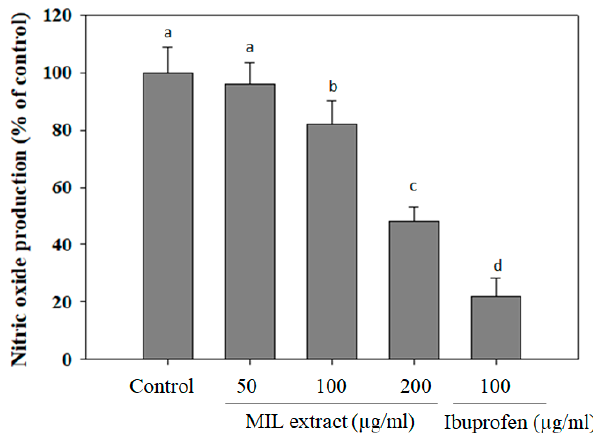
Figure 5. Inhibitory effect of M. indica leaves (MIL) extract on NO production from LPS-stimulated RAW 264.7 cells. The cells were treated with the extract for 12 h prior to stimulation of LPS for 12 h. Aliquots (50 µL) of supernatants was incubated with 50 µL of Griess reagent for 15 min. Absorbance was measured at 540 nm. Ibuprofen was used as a positive control. The results were expressed as percentage of control. Each determination was made in three independent experiments, and the data are shown as means ± SD. Different letters a–d indicate significant difference among groups ( p < 0.05) by Duncan’s multiple-range test.